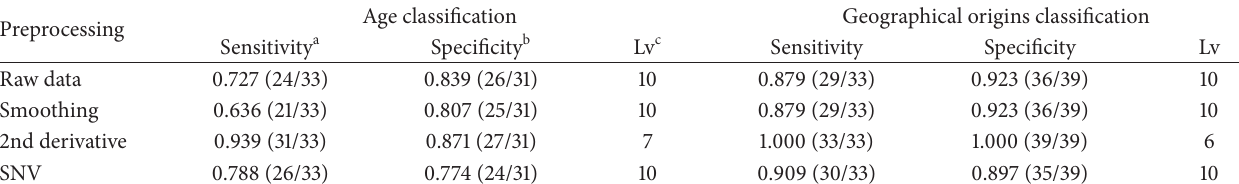
Table 2: Discrimination of age and geographical origins of T. grandis seeds by PLSDA.